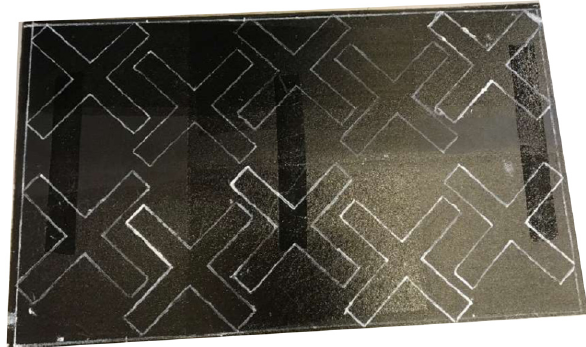
Figure 1: Cruciform specimens in the manufactured panel.